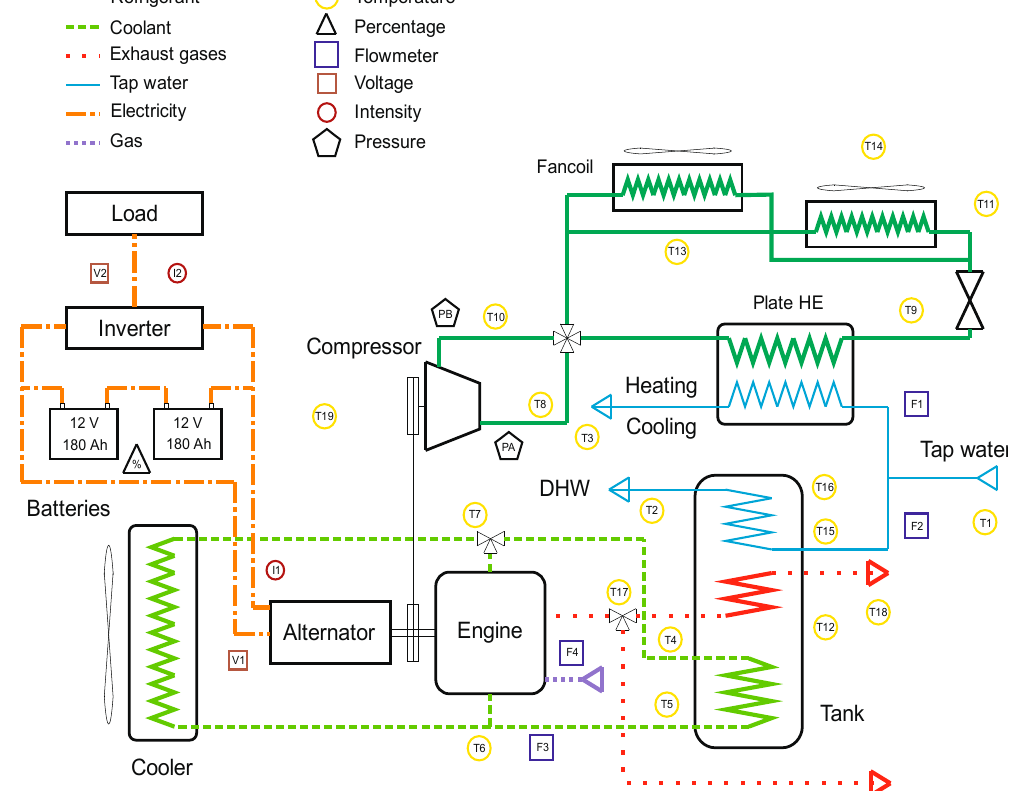
Figure 6. Trigeneration unit components [37].